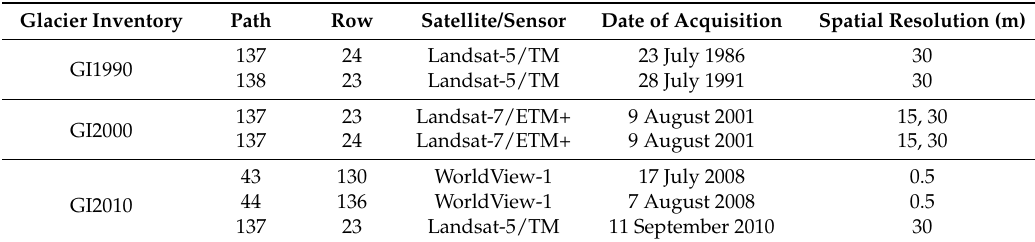
Table 1. Remote sensing data used in this